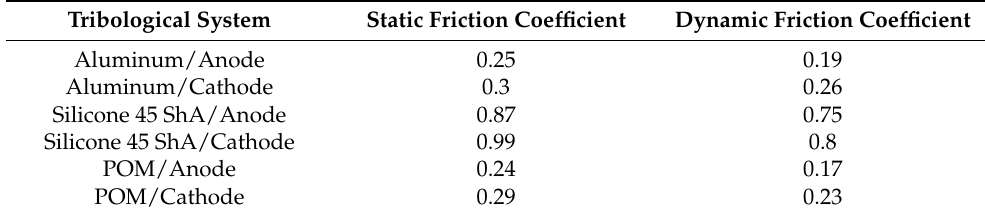
Table 3. Measurements from the edge collision test rig.